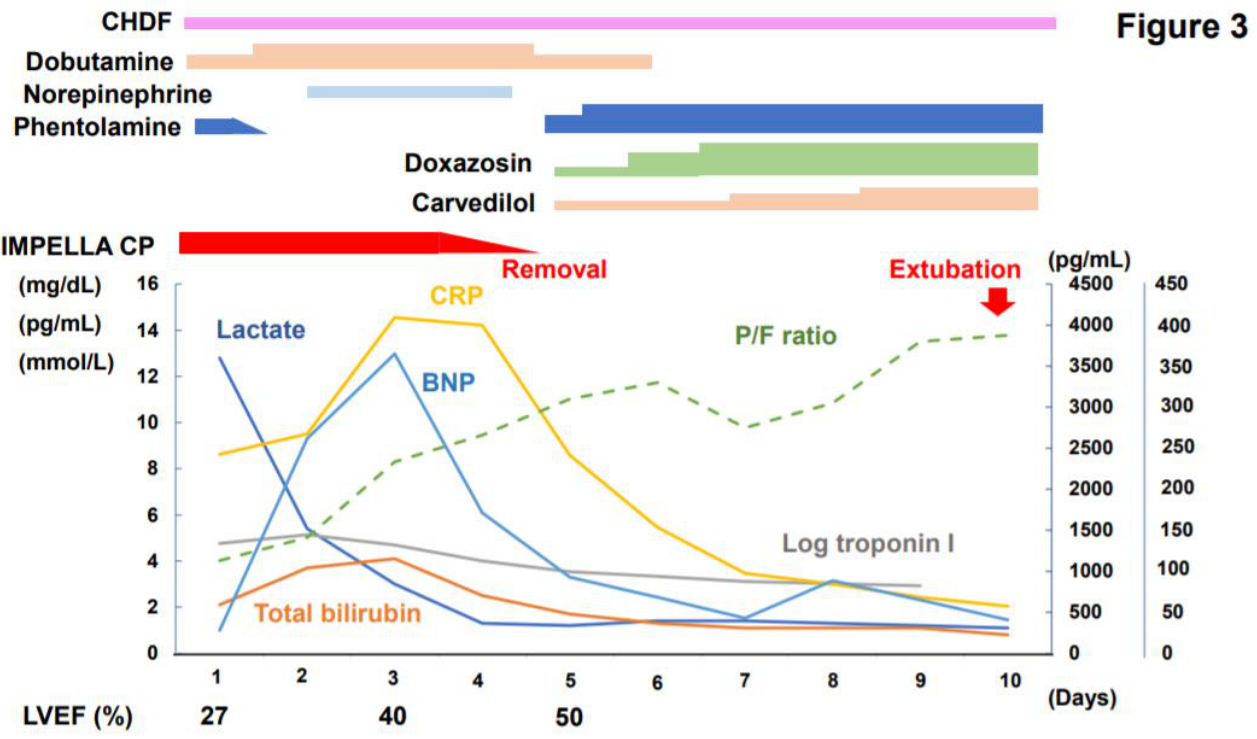
Figure 3. Clinical course after Impella support initiation. CRP, C-reactive protein; BNP,